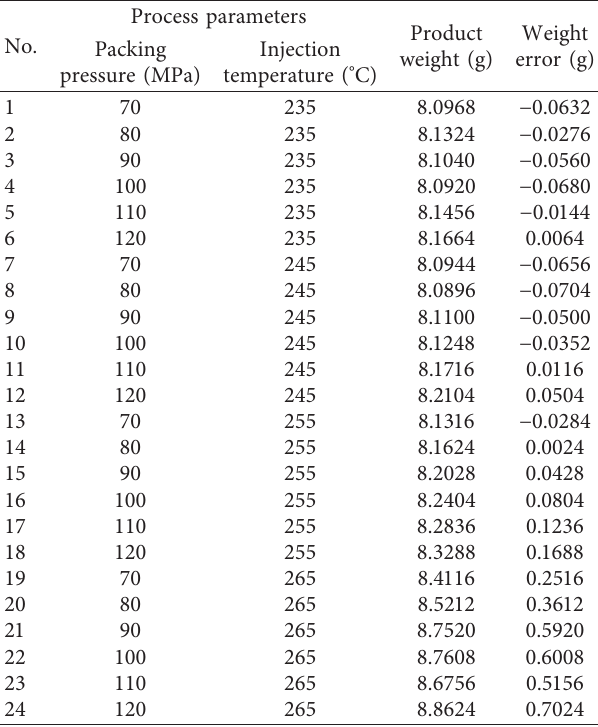
Table 1: Weight under each parameter